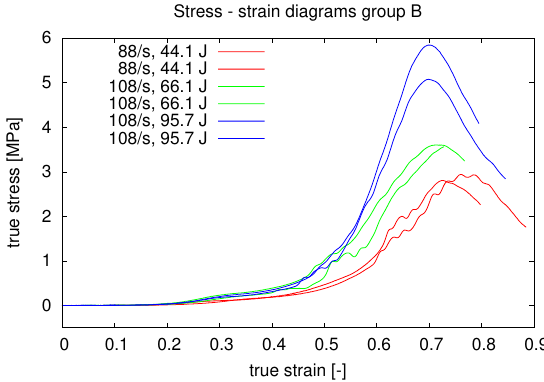
Figure 5. Stress-strain curves of drop tests of group B (polymer meshwork filled with ordnance gelatine).